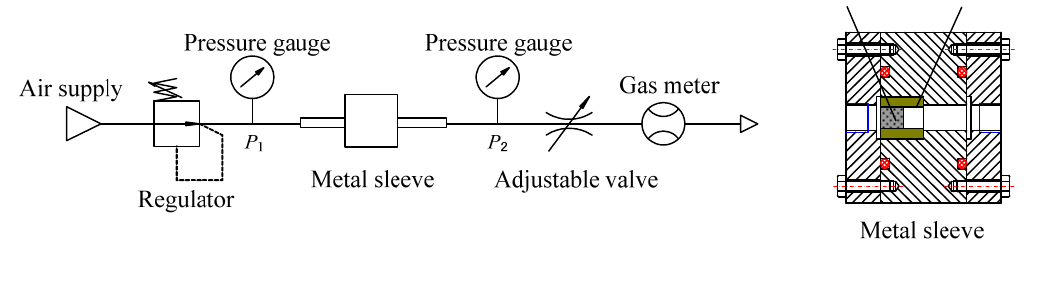
Figure 3. Schematic of experimental